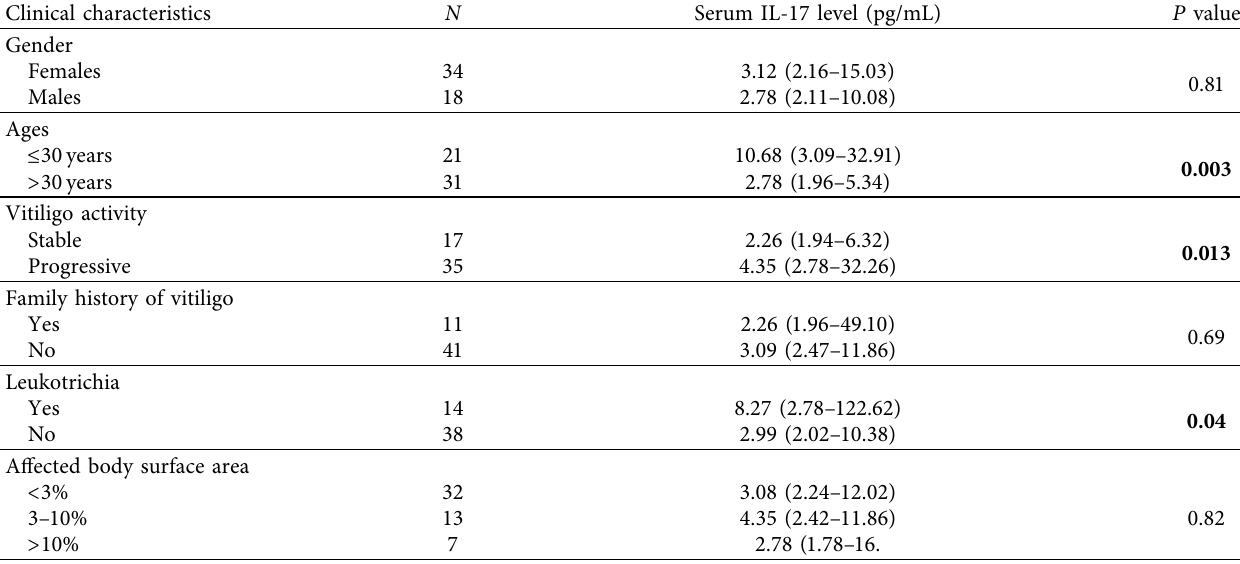
Table 2: The association of serum IL-17A levels with clinical characteristics of vitiligo patients.